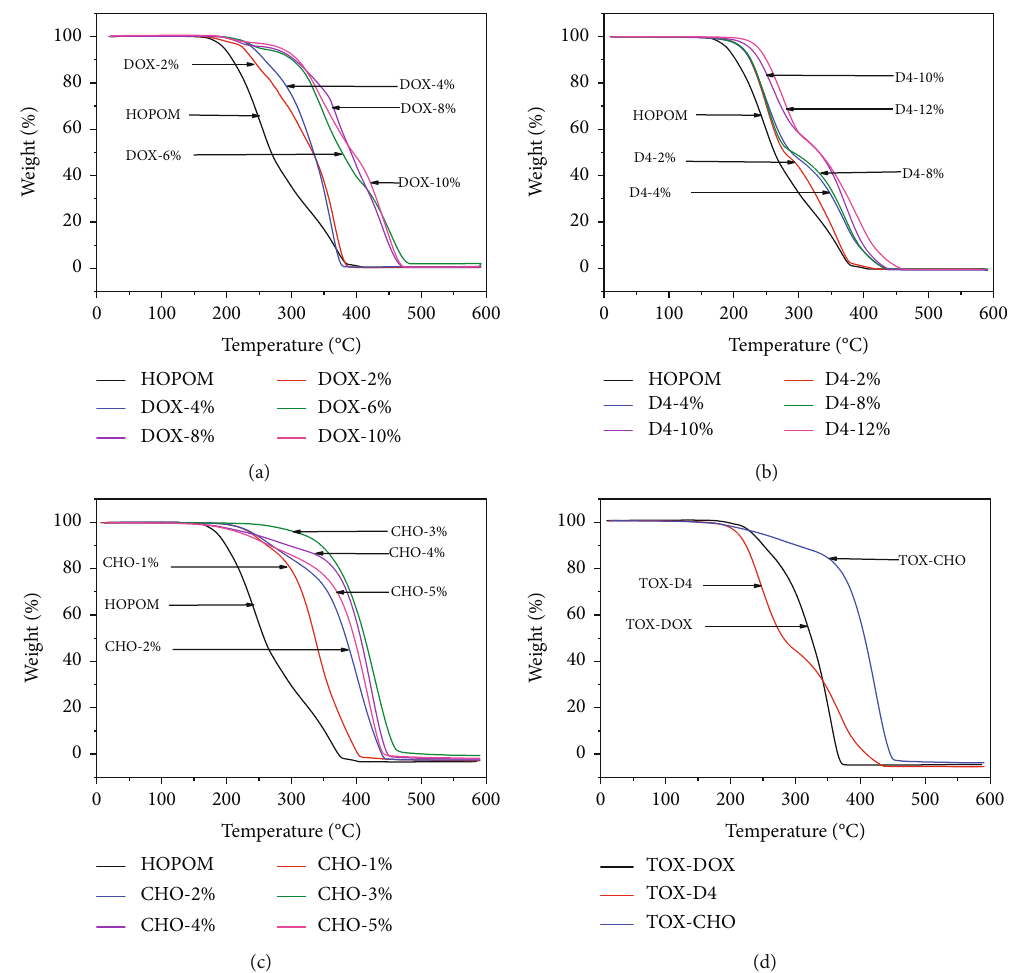
Figure 3: TGA curves of the copolymer. (a) Changes in the dosage of DOX. (b) Changes in the dosage of D4. (c) Changes in the dosage of CHO. (d) Comparison of the second monomer (4